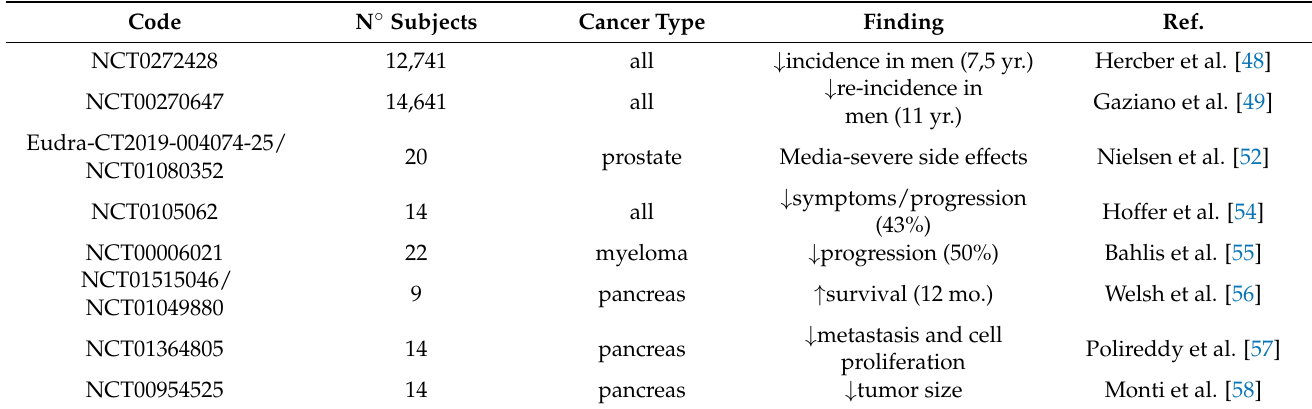
Table 1. Clinical